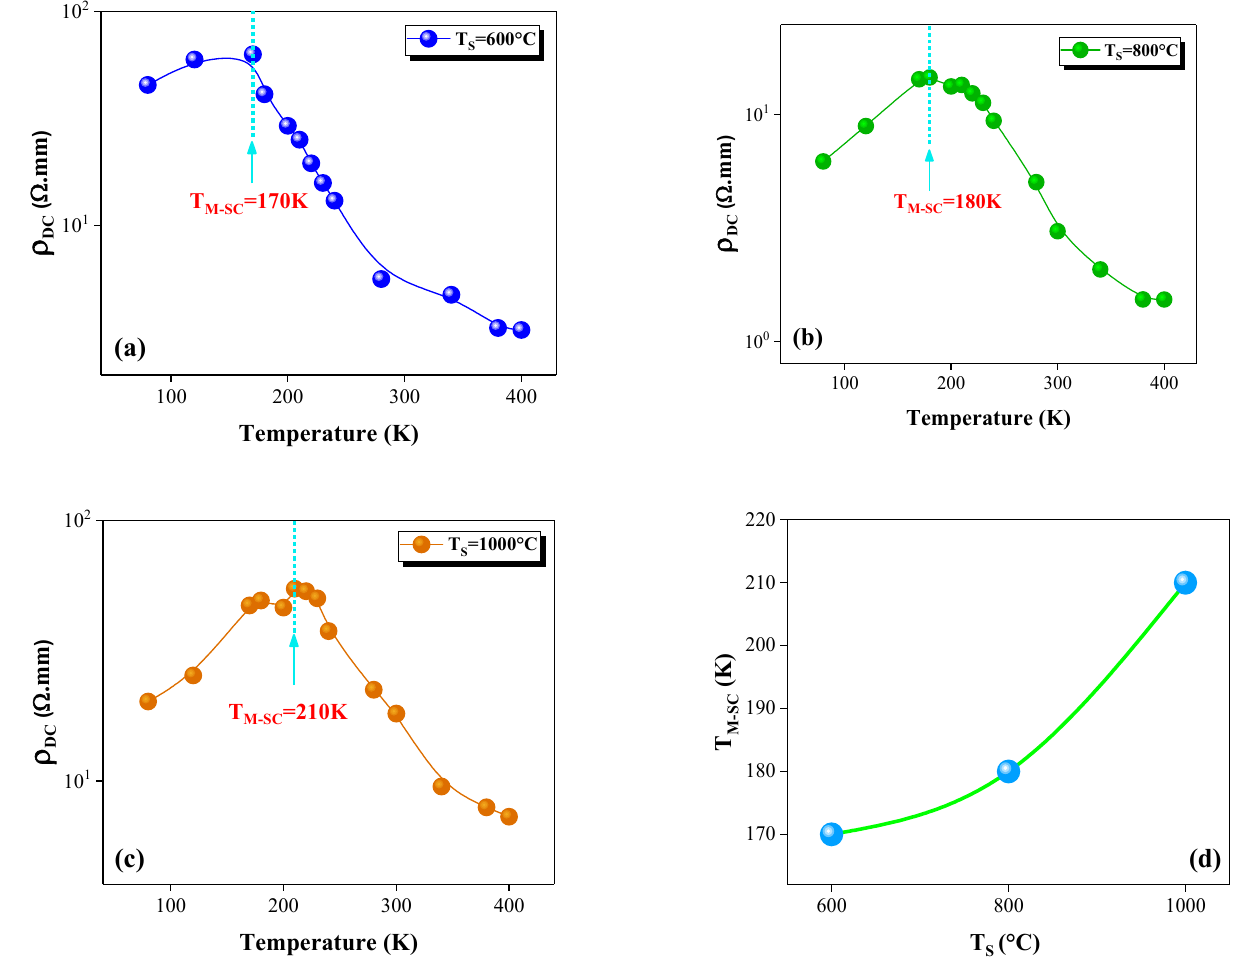
Figure 2. Temperature dependence of the electrical DC ‐ resistivity for the La 0.9 Sr 0.1 MnO 3 compound at different sintering temperatures (T S = 600 °C ( a ), 800 °C ( b ), and 1000 °C ( c )). Evolution of T M ‐ SC with sintering temperature T S ( d ).